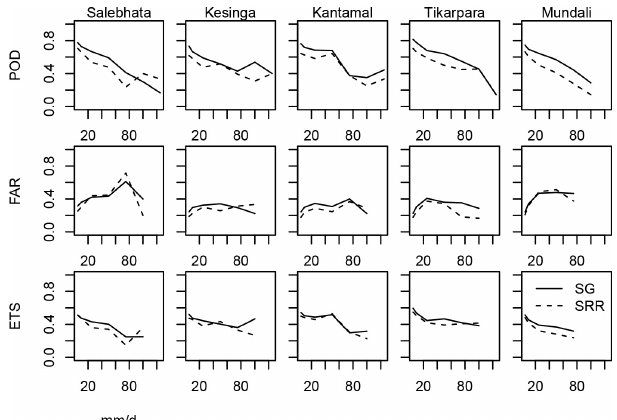
Figure 3. Probability of detection (POD), false alarm ratio (FAR) and equitable threat score (ETS) of satellite-based estimates of daily areal precipitation for selected thresholds ( x axis). Data set labels according to Table 2. Columns correspond to the sub-catchments shown in Fig. 1.